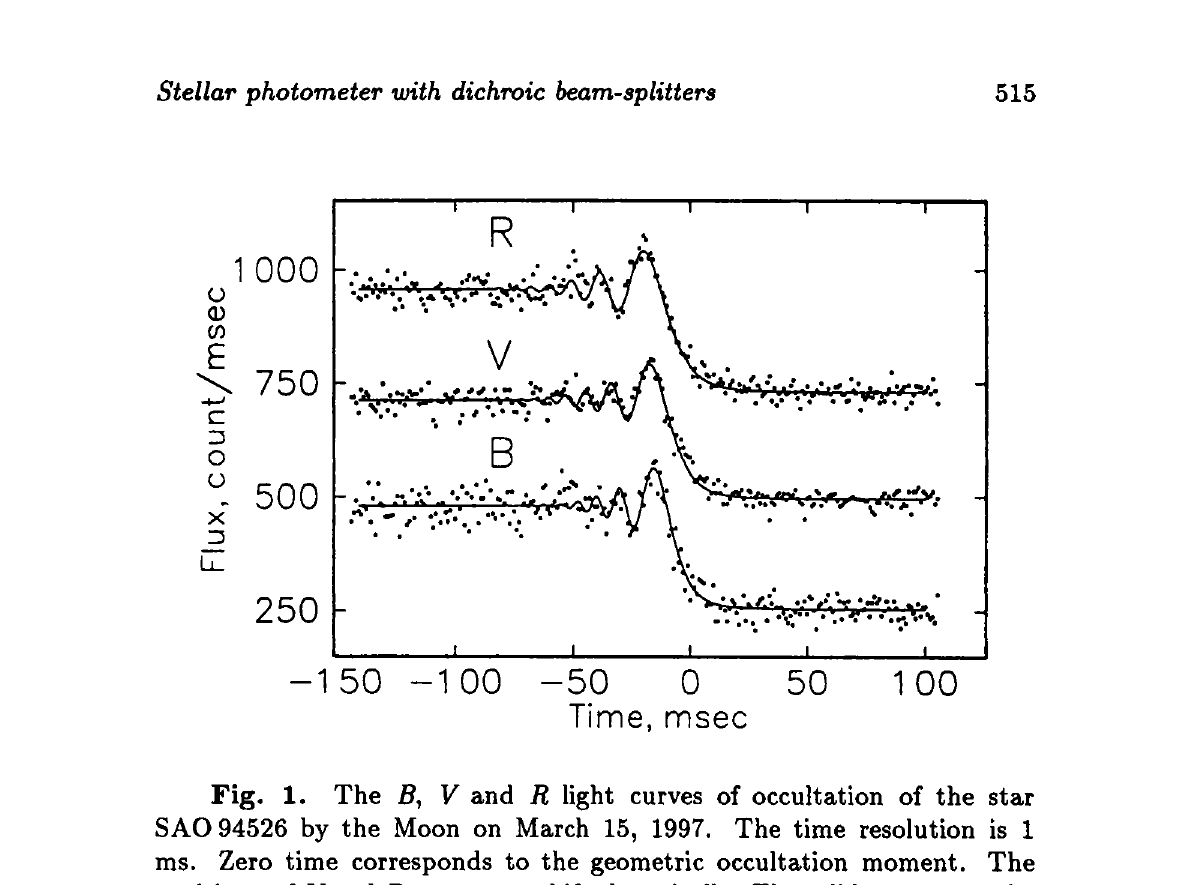
Fig. 1. The B, V and R light curves of occultation of the star SAO 94526 by the Moon on March 15, 1997. The time resolution is 1 ms. Zero time corresponds to the geometric occultation moment. The positions of V and R curves are shifted vertically. The solid curves are the light curves predicted